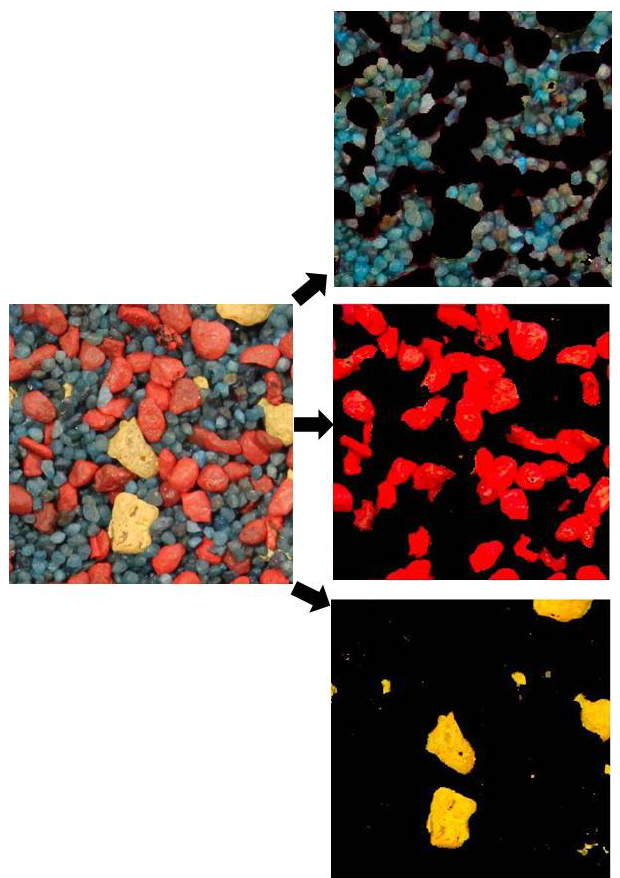
Figure 6. Colour segmentation for the three grain-size